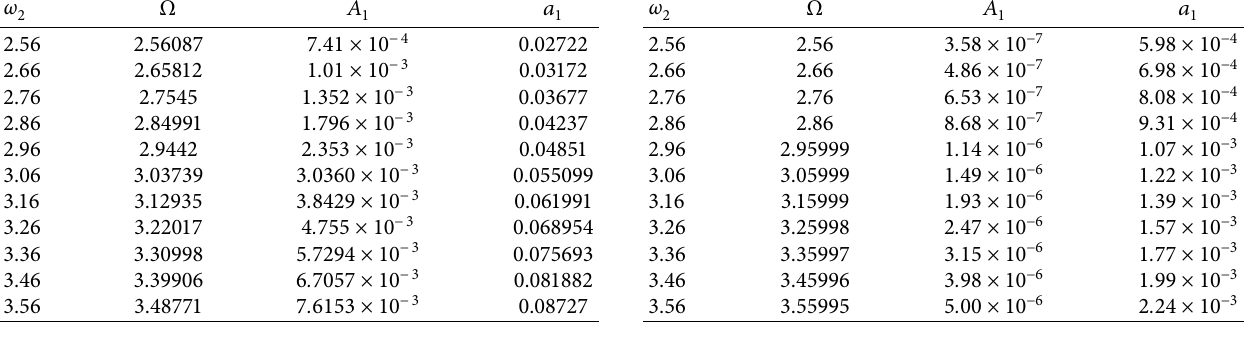
� 0 . 02 , τ � 0 . 01 , σ � 0 . 28 ,y � 0 . 07 with the initial condition 1 2 1 0 Table 2: Different minimum points of amplitude a when 1 + τ � 0 . 05. 1 2